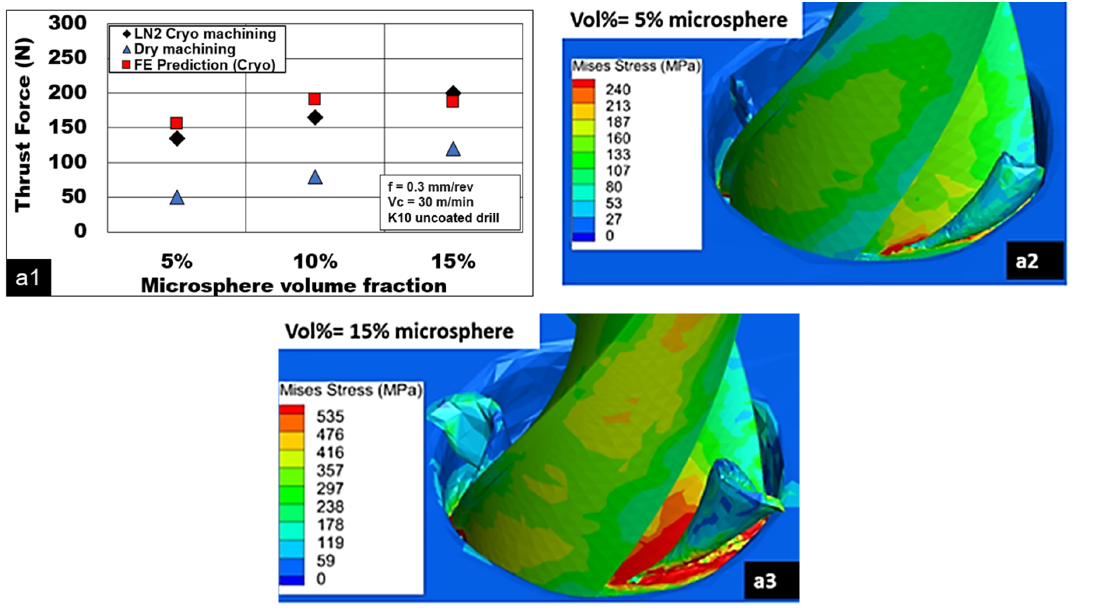
Figure 5. ( a1 ) Effect of alumina volume fraction on thrust force during machining Mg-9Al-1.4Zn reinforced with varying vol% of hollow alumina microspheres, and ( a2,a3 ): von Mises stress distribution for Mg 5% and 15% hollow alumina foams. (V = 30 m/min, f = 0.3 mm/rev, K10-uncoated drill, cryogenic cooling.).